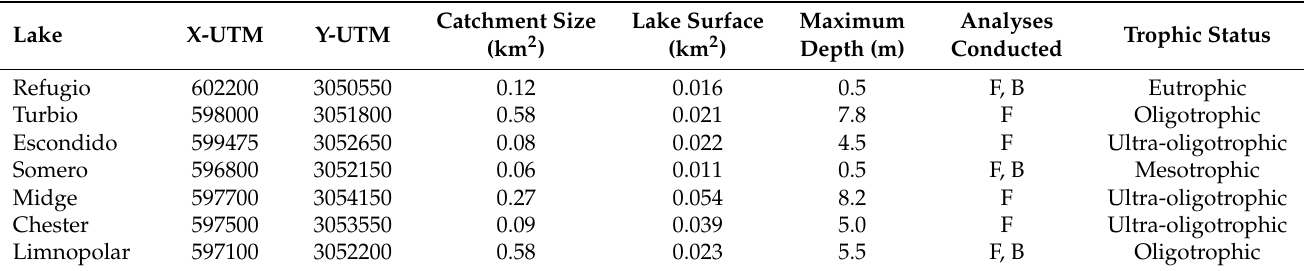
Table 1. Geographical location and main characteristics of the studied lakes from Byers Peninsula. In the analysis column, F stands for the analysis performed with FAPROTAX, whereas B stands for those performed with Biolog Ecoplates. The estimation of the trophic status of lakes is based in Rochera et al.